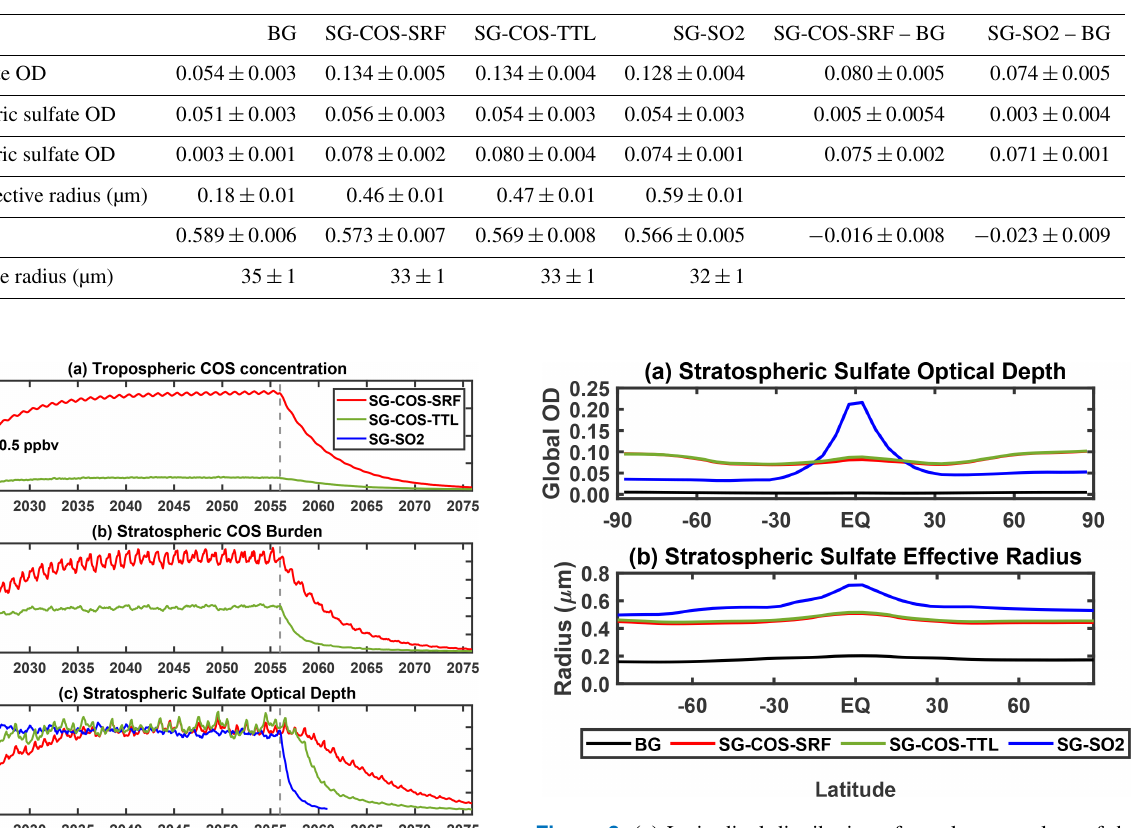
Figure 3. (a) Latitudinal distribution of zonal mean values of the stratospheric sulfate optical depth for the BG (black), SG-COS-SRF (red), SG-COS-TTL (green), and SG-SO2 (blue) cases. (b) Strato- spheric effective radius (in µm, from the tropopause to 6hPa). All quantities are annually averaged over the years